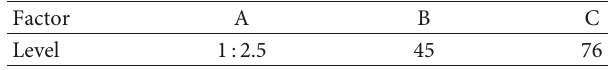
Figure 3: Average strength change of paste filling material. Table 5: Proportion of paste filling